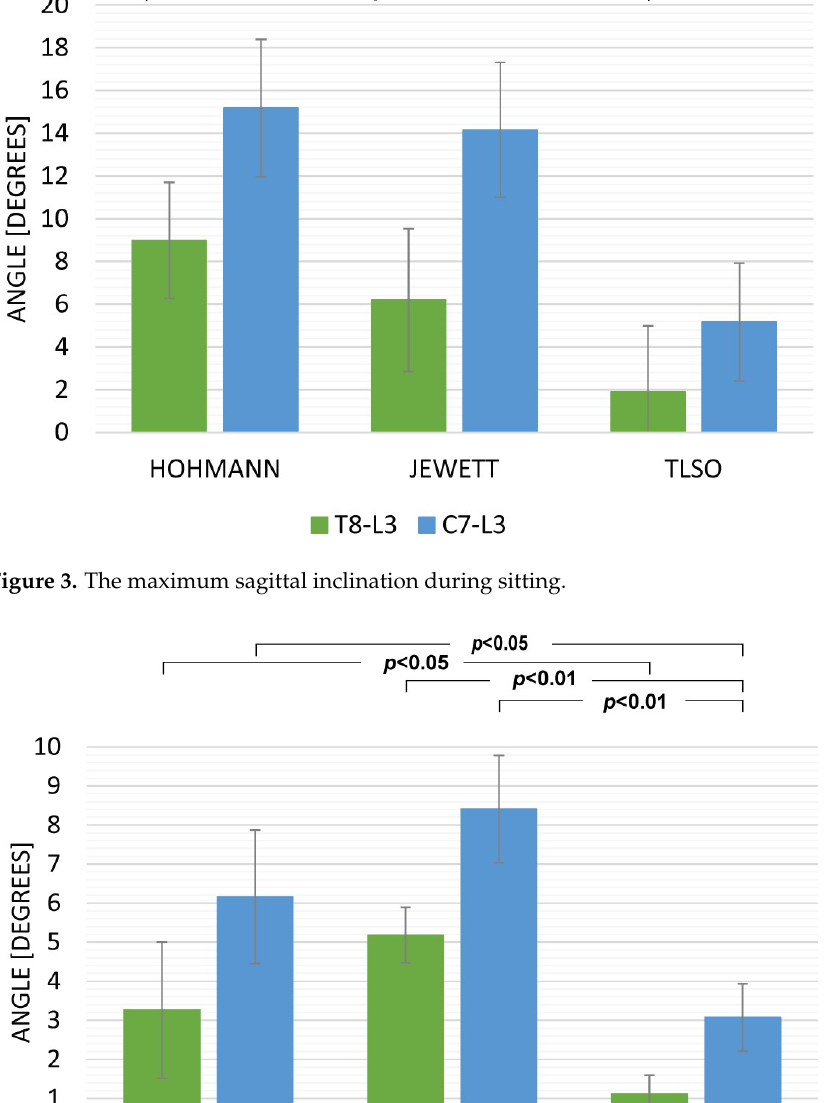
Figure 5. The maximum sagittal inclination while lifting an object from the floor.